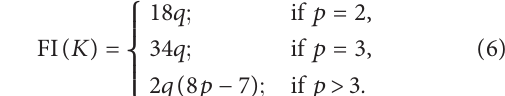
Table 3: Numbers of f